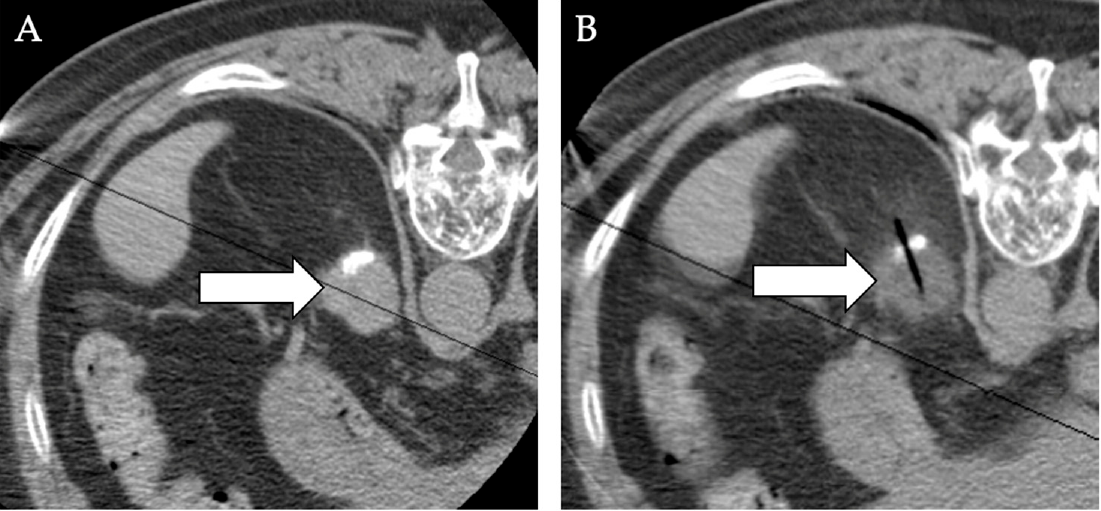
Figure 12. Cryoablation of adrenal tumor . ( A ) Axial CT image in an HCC patient with a single metastatic focus to the left adrenal (white arrow). ( B ) During cryoablation the entire mass (white arrow) demonstrates lowered HU as its density decreases during freezing. The “ice-ball” is difficult to visualize in fatty regions because its CT density is very close to that of fat. The peri-adrenal fat becomes “fuzzy” indicating extension of the “ice-ball” around the adrenal mass.